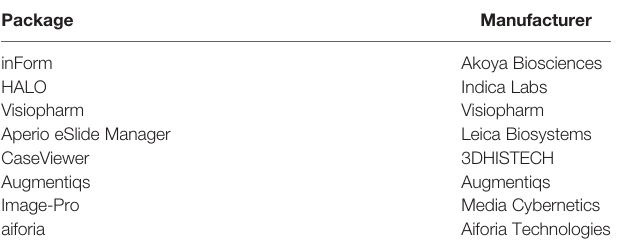
TABLE 2 | Representative and commercially available digital image analysis software